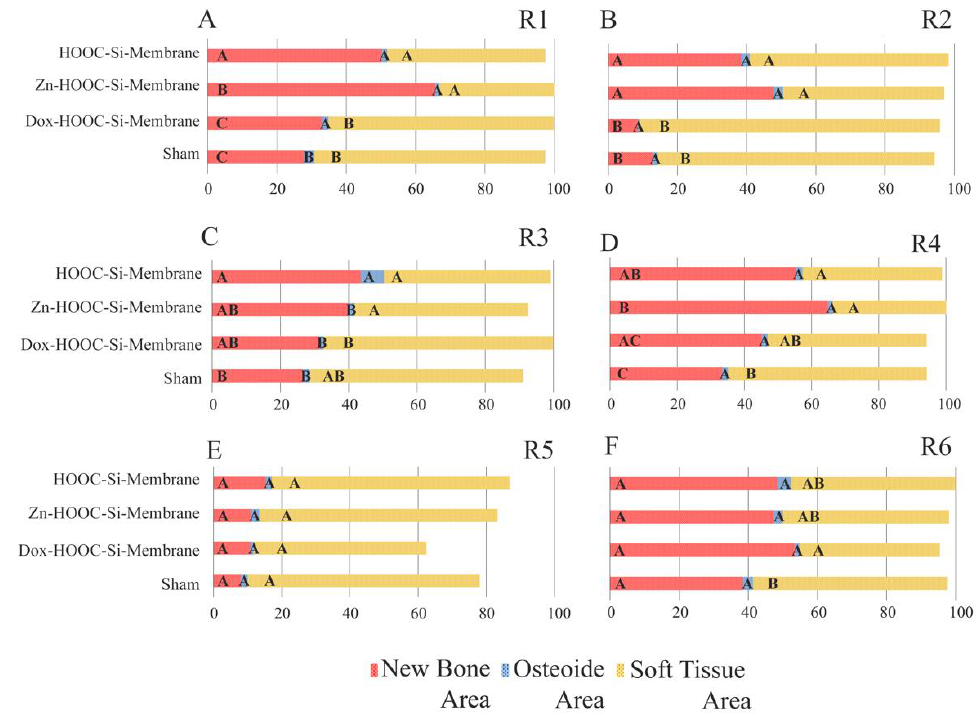
Figure 9. Histomorphometric study of the new bone area (NBA, in red), osteoid area (OA, in blue), and soft tissue area (STA, in yellow) fractions in each of the six regions of the grid comparing the four groups of study. Same letters within each color indicate no significant differences. ( A – F ) represent the different regions in which the defect is divided from R1 to R6.